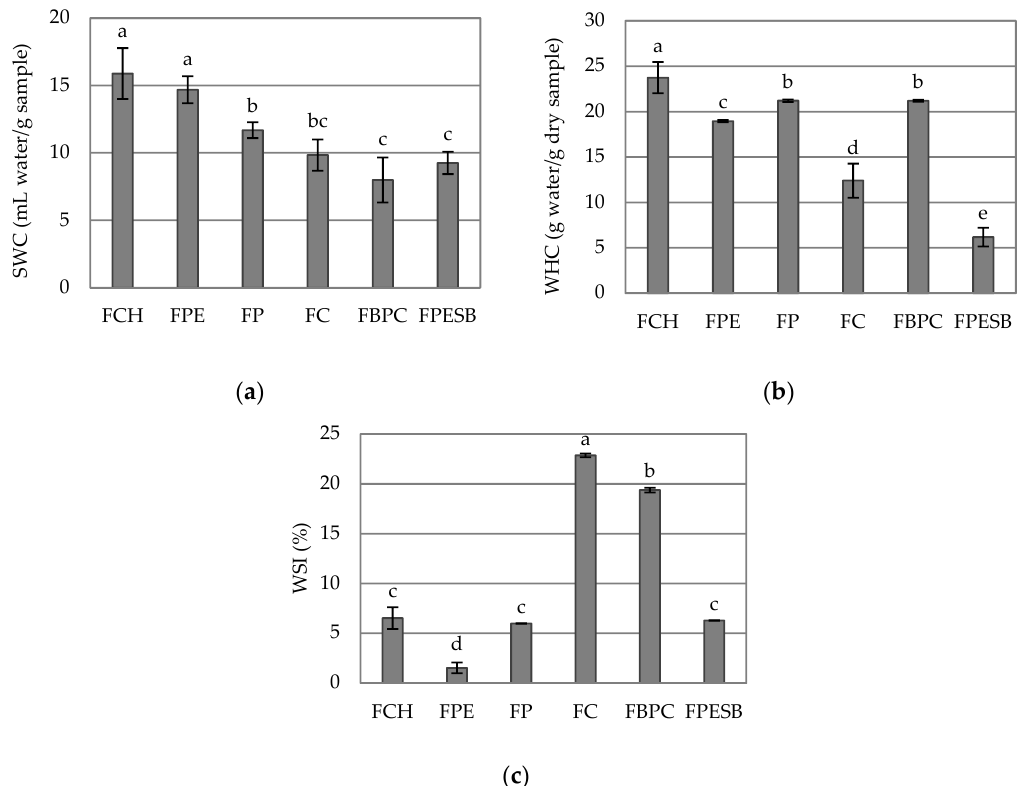
Figure 2. Mean values and standard deviations of ( a ) the swelling capacity (SWC), ( b ) the water-holding capacity (WHC) and ( c ) the solubility (WSI) of the DF samples. Letters indicate the homogeneous groups established by the ANOVA ( p < 0.05).